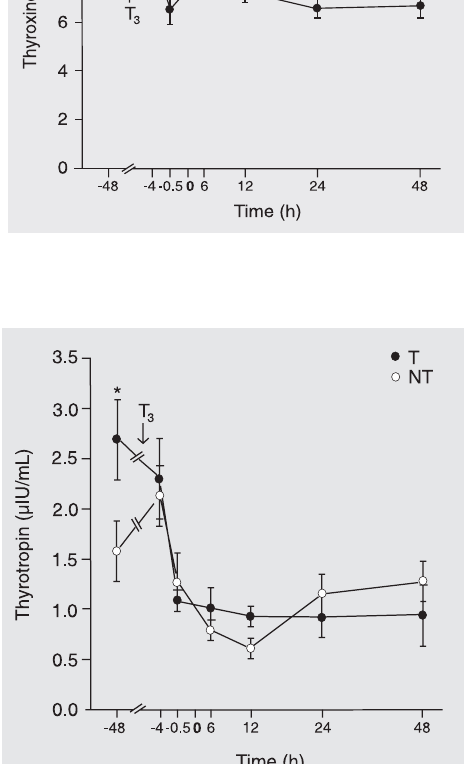
Figure 2. Serum thyroxine in the groups studied. T = T 3 -treated group, N = 8; NT = placebo-treated group, N = 10; -48 = 2 days before cross-clamp re- moval (baseline); -4 = 1 h before going into surgery and 4 h before cross-clamp removal (24 h after the begin- ning of T 3 or placebo); -0.5 = within 30 min of cardiopul- monary bypass; 0 = cross-clamp removal; 6 = 6 h after aortic cross-clamp removal; 12 = 12 h after aortic cross- clamp removal; 24 = 24 h after aortic cross-clamp removal; 48 = 48 h after aortic cross-clamp removal. *P < 0.05 compared to control (ANOVA for repeated meas- ures; post hoc Student-Newman-Keuls test).